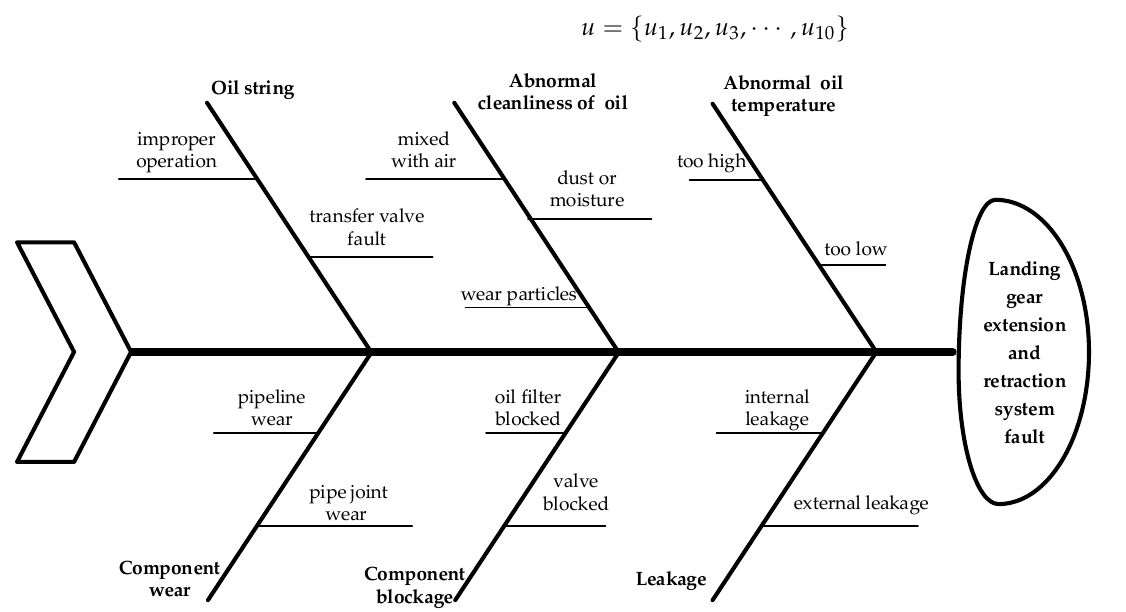
Figure 3. Failure mode fishbone diagram.